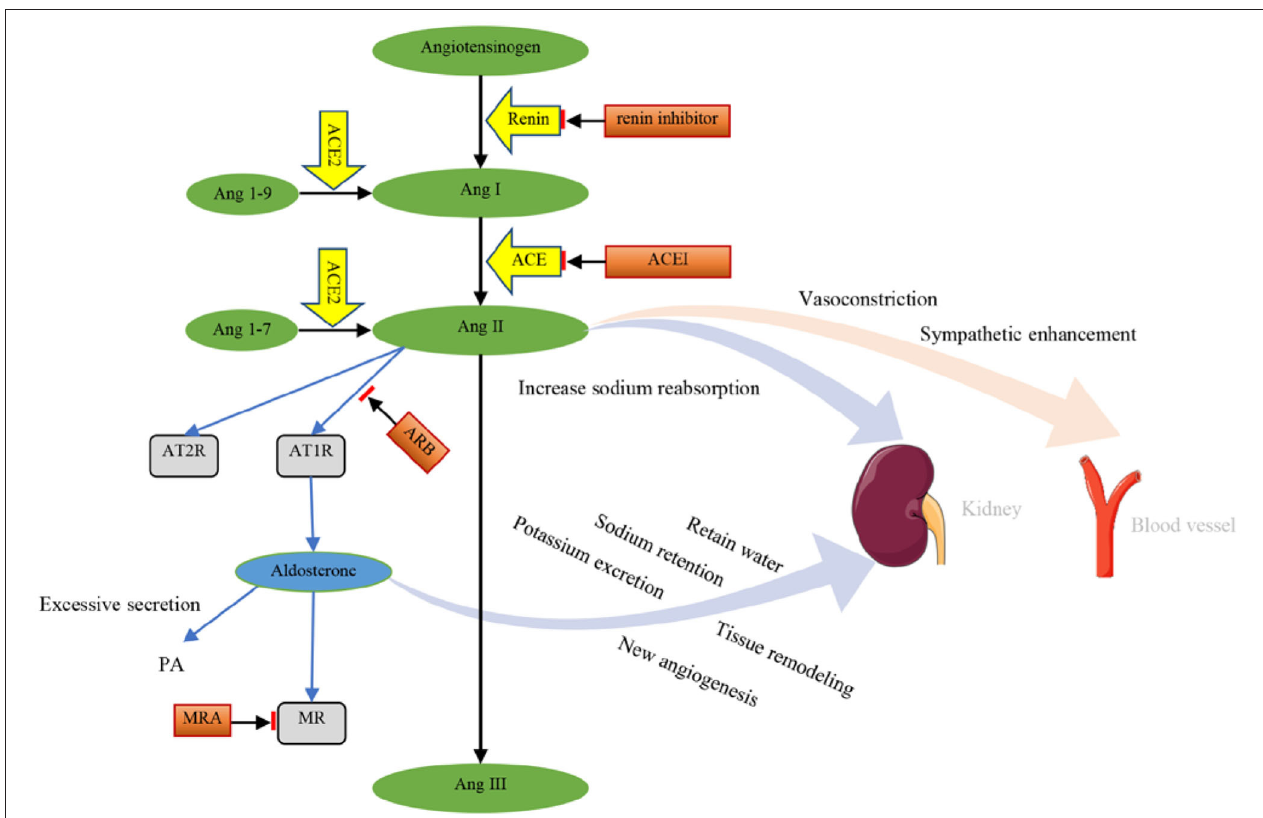
FIGURE 1 | Components and effects of the RAAS. Renin cuts 10 peptides (Ang I) from angiotensinogen. The effect of renin can be inhibited by renin inhibitors. Ang I is further cleaved to Ang II by ACE. ACEI can inhibit the effect of ACE. Ang I and Ang II are converted into Ang1-9 and Ang1-7 by ACE2, respectively. Then, Ang II is converted into Ang III. Ang II acts on AT1R and AT2R. The effects of Ang II on AT1R can be blocked by ARB. Ang II promotes vasoconstriction and sympathetic enhancement and increases renal tubular reabsorption of sodium. Aldosterone retains water and promotes sodium retention, potassium excretion, tissue remodeling, and angiogenesis. Excessive secretion of aldosterone causes PA. Aldosterone acts on MR, which can be blocked by MRA. Ang I, angiotensin I; Ang II, angiotensin II; ACE, angiotensin converting enzyme; ACEI, angiotensin converting enzyme inhibitor; Ang1-9, angiotensin 1-9; Ang1-7, angiotensin 1-7; Ang III, angiotensin III; AT1R, angiotensin II receptor 1; AT2R, angiotensin II receptor 2; ARB, angiotensin receptor blocker; MR, mineralocorticoid receptor; MRA, mineralocorticoid receptor antagonism; PA, primary